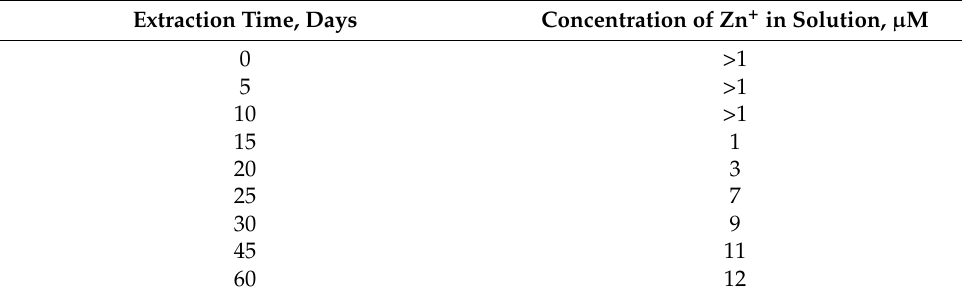
Table 5. Effect of extraction time on the release of Zn + from a polymer.